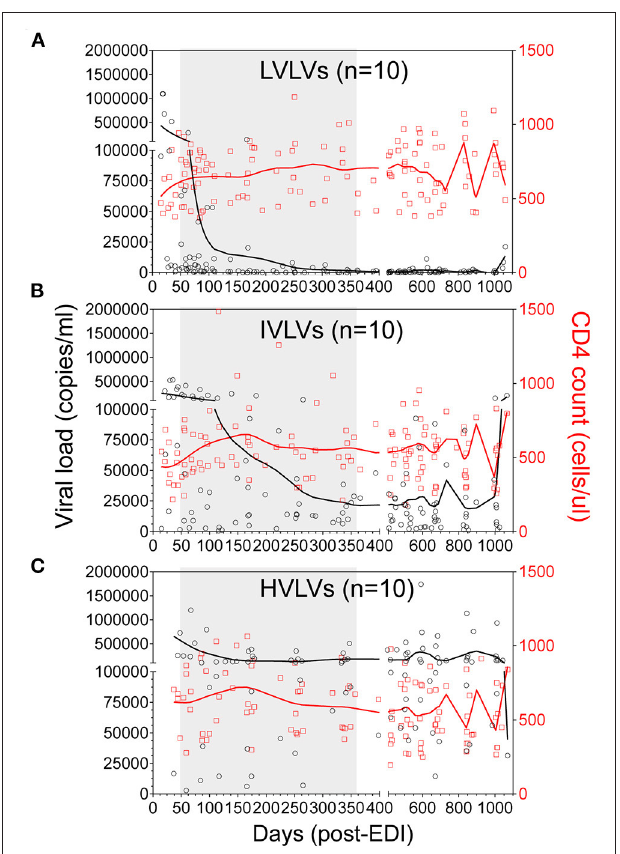
FIGURE 4 | Locally weighted scatterplot smoothing (LOWESS) curves showing the overall trend in VL (black circles) and CD4 counts (red squares) for Low viral load volunteers (LVLVs) (A) , Intermediate viral load volunteers (IVLVs) (B) and High viral load volunteers (HVLVs) (C) over 36 months post infection. N = 10 for each group. The shaded region indicates the dynamic period of immune control observed in the LVLVs following peak